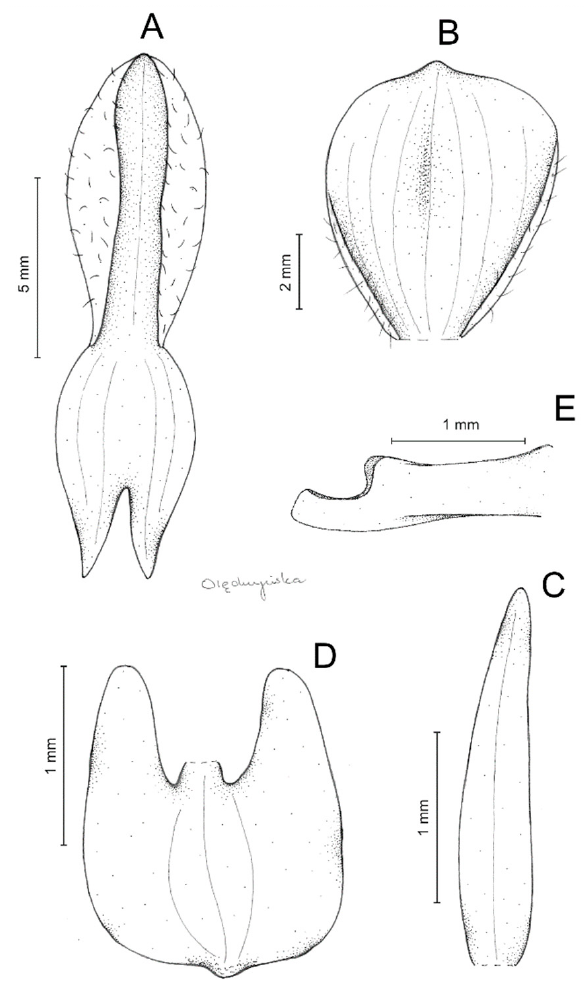
Figure 13. Neooreophilus medinae Kolan. & Szlach.—dissected perianth. ( A )—sepals, ( B )—dorsal sepal, ( C )—petal, ( D )—lip, ( E )—gynostemium. Drawn by N. Ol˛edrzy´nska from the